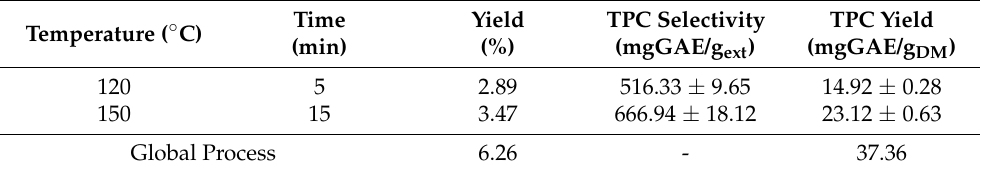
Table 8. Extraction yield and TPC analyses for double sequential extraction.